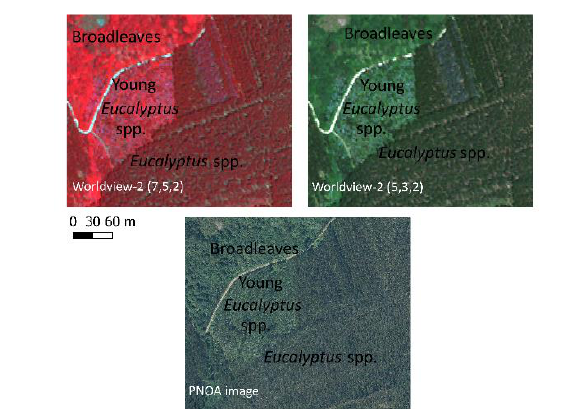
Figure 5. Detail of Worldview-2 images of Eucalyptus spp. and broadleaf stands. Reference image PNOA (IGNb, 2021).